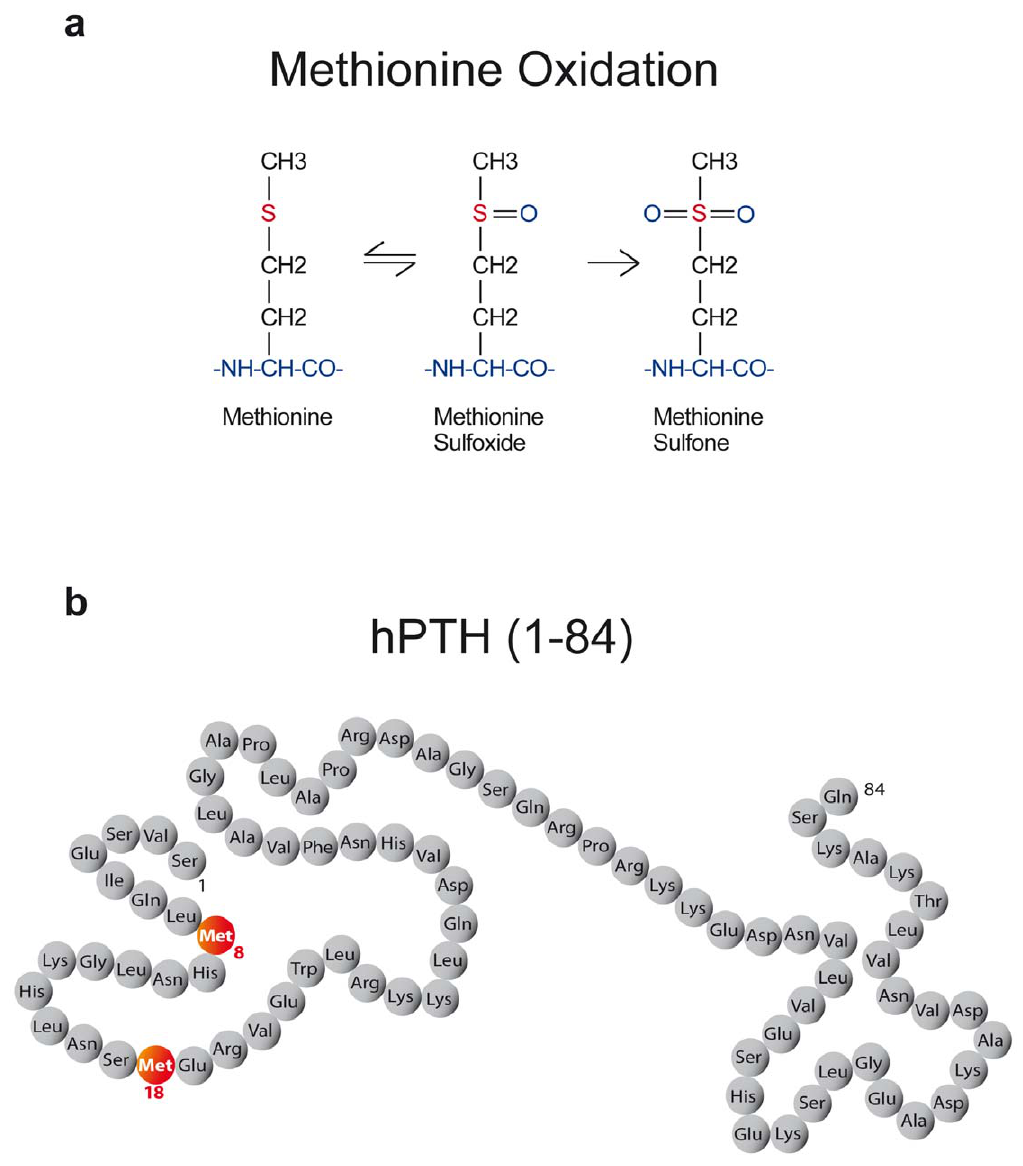
Figure 1. A: Under conditions of oxidative stress the methionine residues at position 8 and 18 may be oxidized to methionine sulfoxide and methionine sulfone. Oxidation to methionine sulfoxide is reversible, whereas the second oxidation step to methionine sulfone is irreversible. Oxidized PTH changes its 3-dimesional structure. This blocks the interaction of PTH with its receptor. B: Schematic diagram of the full length PTH(1–84) molecule (‘‘bioactive’’ intact PTH). Oxidation at position Met 8 and/or Met 18 (red) alters the receptor binding site of PTH. Oxidized PTH does not bind the PTH receptor anymore and is thus biologically inactive. (see: E. Blind, Clin. Lab. 2008;54:439-446, reference 3).